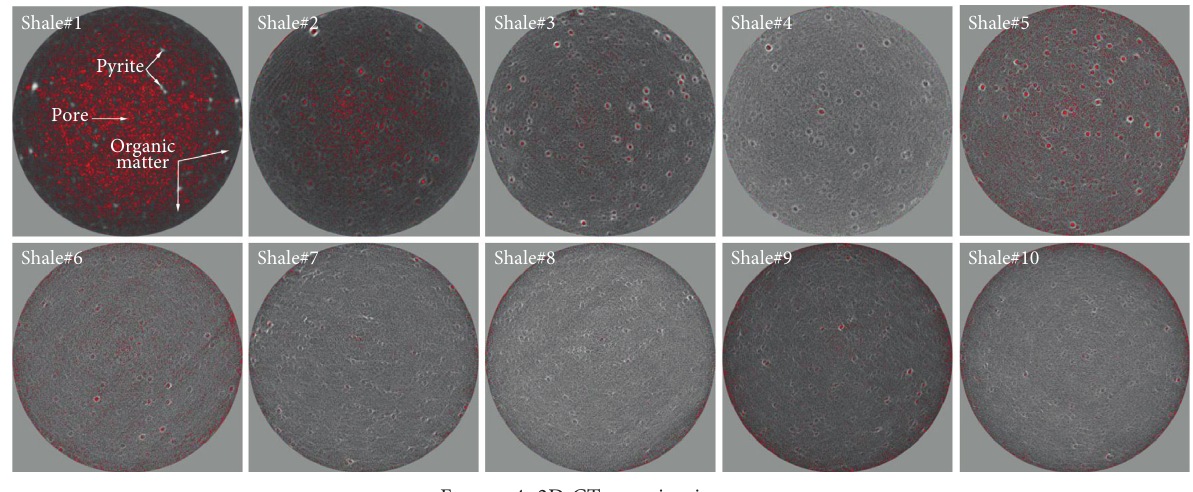
Figure 4: 2D CT scanning images.